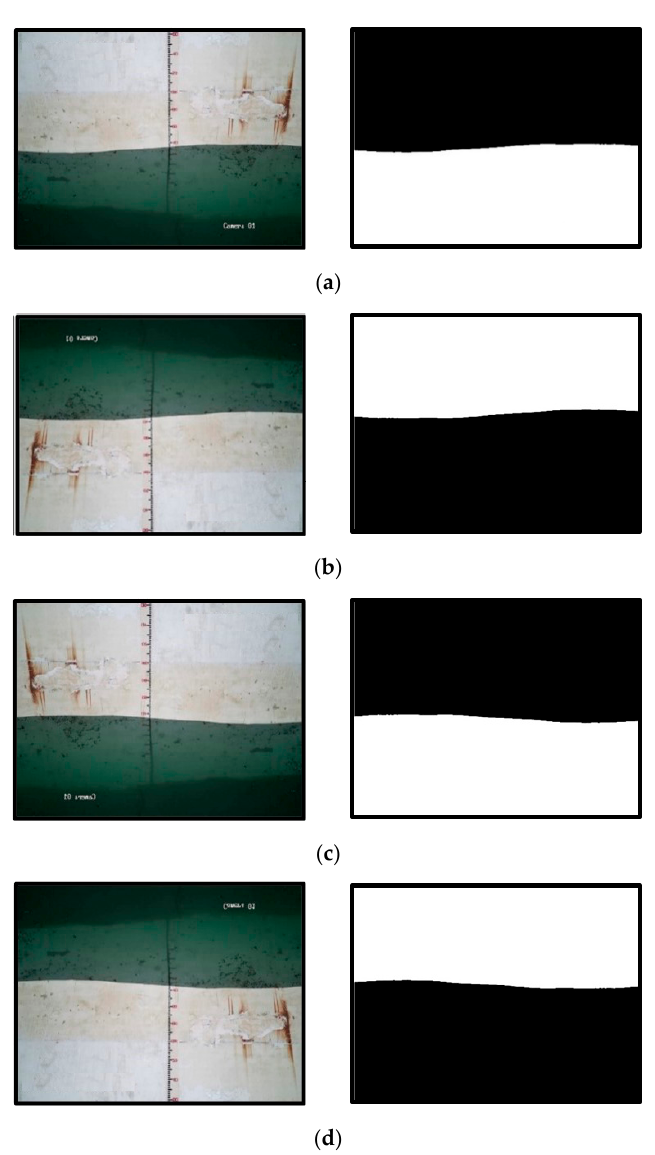
Figure 3. Data augmentation results. ( a ) Original image and its label, ( b ) Flip 180° clockwise and its label, ( c ) Horizontal mirroring and its labels, ( d ) Vertical mirroring and its labels.